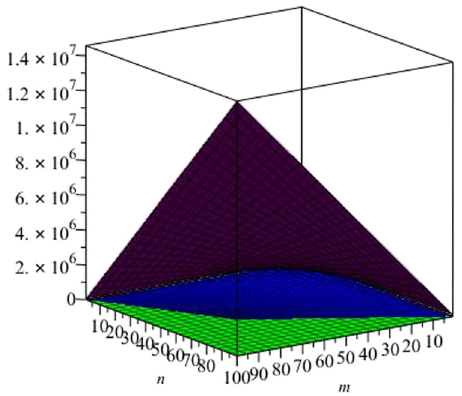
Figure 6: Comparison of fi rst K - Banhatties